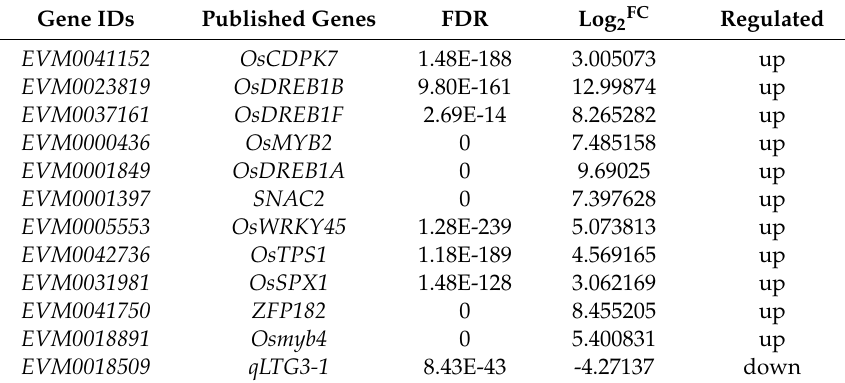
Table 2. Our DEGs in cold stress tolerance genes previously cloned.